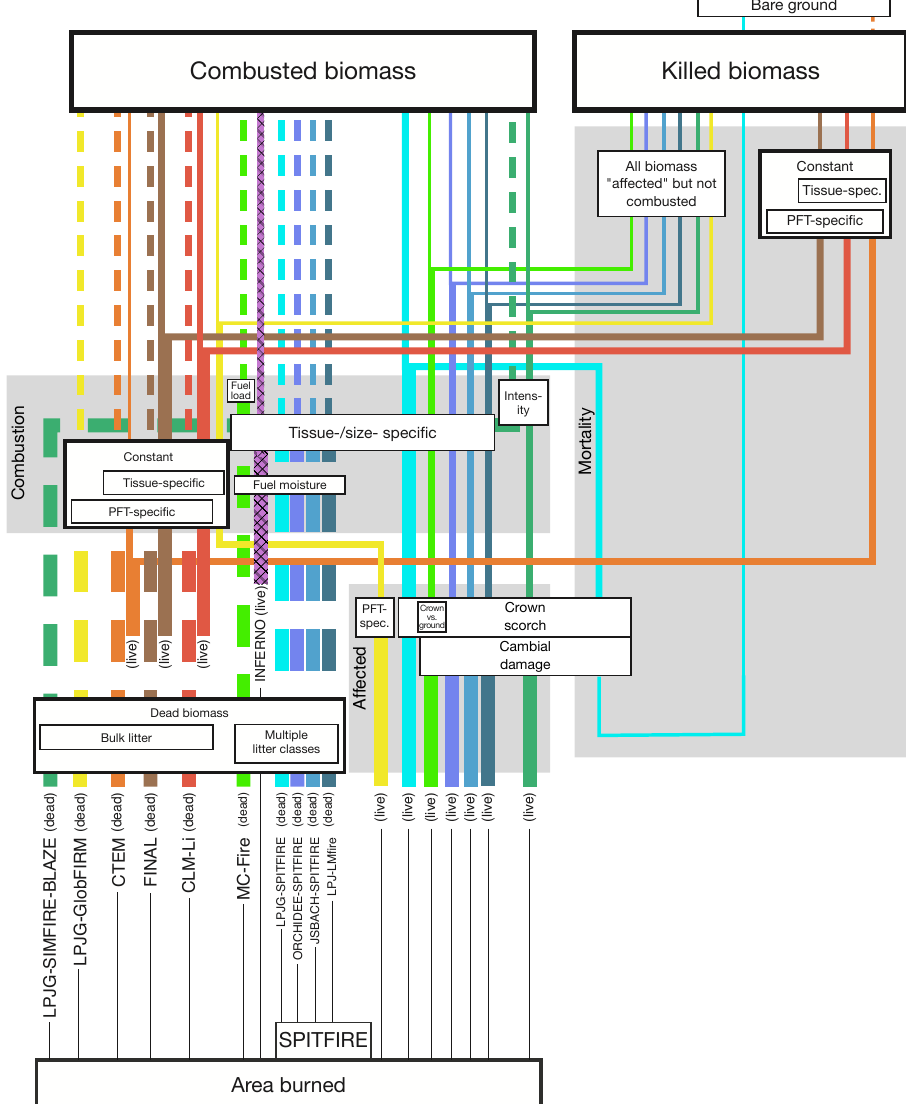
Figure 5. Modeled processes leading from burned area (bottom; Fig. 4) to fire combustion and mortality (top). We distinguish between combusted and killed biomass based on whether it is transferred to the atmosphere or to litter/soil pools, respectively. For live biomass, the order in which combustion and fire mortality are simulated differs among the models (Sect. 3); this is illustrated by the location at which lines diverge and where they are reduced in size. In some models, the amount of biomass “affected” by fire depends on simulated “crown scorch” and “cambial damage.” The fraction of biomass combusted is either a constant by vegetation type (“combustion factors”) or a “tissue-/size- specific” function dependent on “fuel moisture,” “fuel load,” and/or fire “intensity.” The fraction of biomass killed is sometimes simply all affected biomass that was not combusted. In other models, constant “mortality factors” for each vegetation type give the fraction of vegetation killed in burns. LPJ-GUESS-SPITFIRE and CTEM can both then simulate the creation of “bare ground” as a result of fire death, although this will be turned off for CTEM in this phase of FireMIP (dashed line). JULES-INFERNO (cross-hatched line) does not calculate fire mortality and only calculates fire emissions diagnostically (i.e., material is not actually transferred from vegetation to the